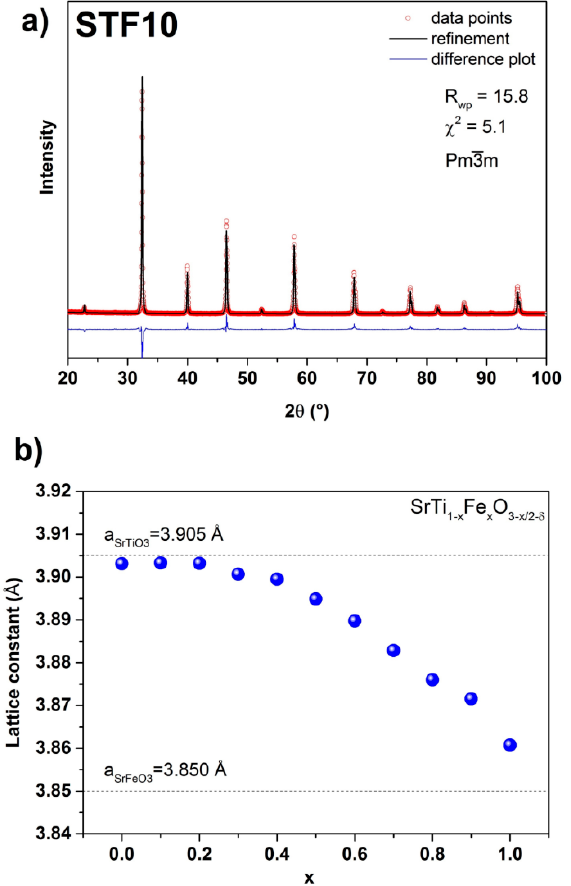
Figure 2. ( a ) Rietveld refinement profile for the SrTi 0.9 Fe 0.1 O 2.95- δ sample; ( b ) unit cell parameter as a function of iron content (x) in SrTi 1 − x Fe x O 3 − x / 2 − δ . Calculated values for SrTiO 3 and SrFeO 3 are shown function of iron content (x) in SrTi 1-x Fe x O 3-x/2- δ . Calculated values for SrTiO 3 and SrFeO 3 are shown as as dashed horizontal dashed horizontal lines.